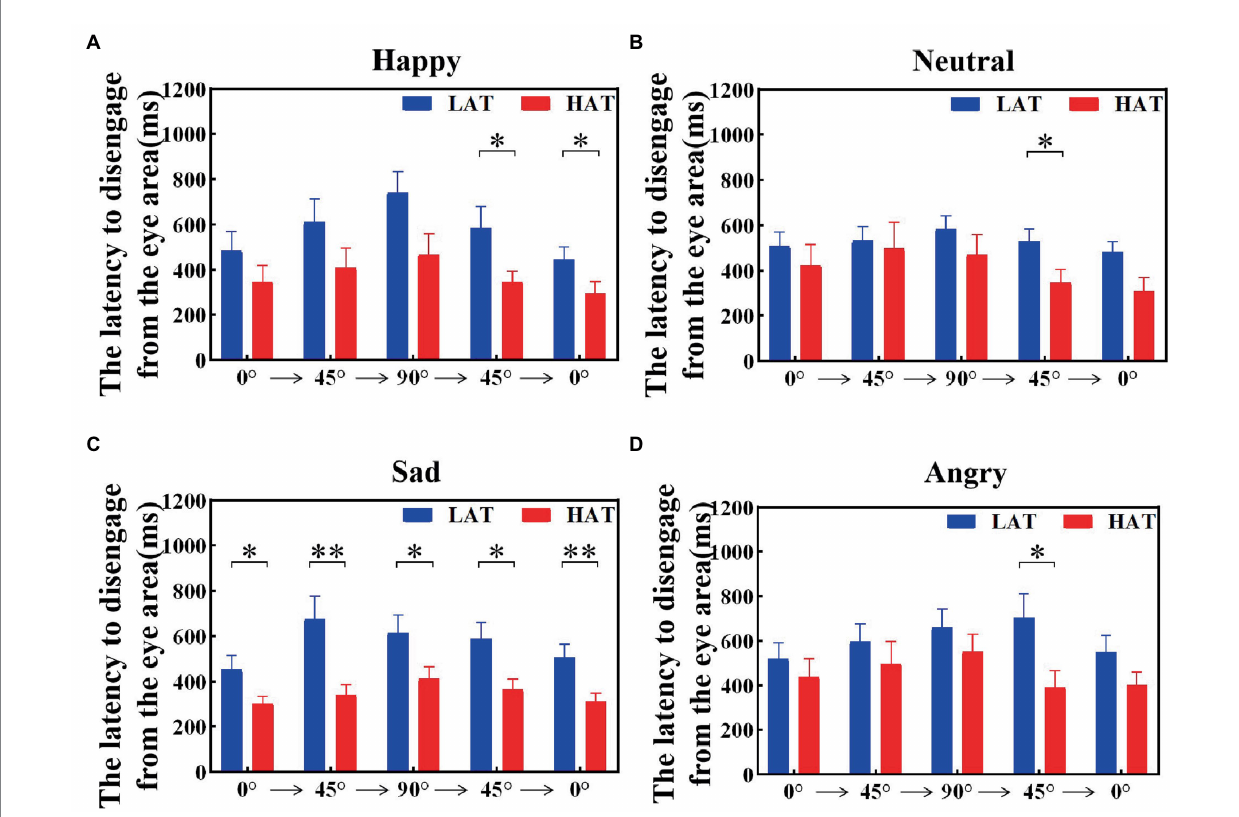
FIGURE 8 The latency to disengage from the eye area of the HAT and the LAT groups during the observation of happy (A) , neutral (B) , sad (C) , and angry (D) emotional faces with different angles in the ‘Front-Side-Front’